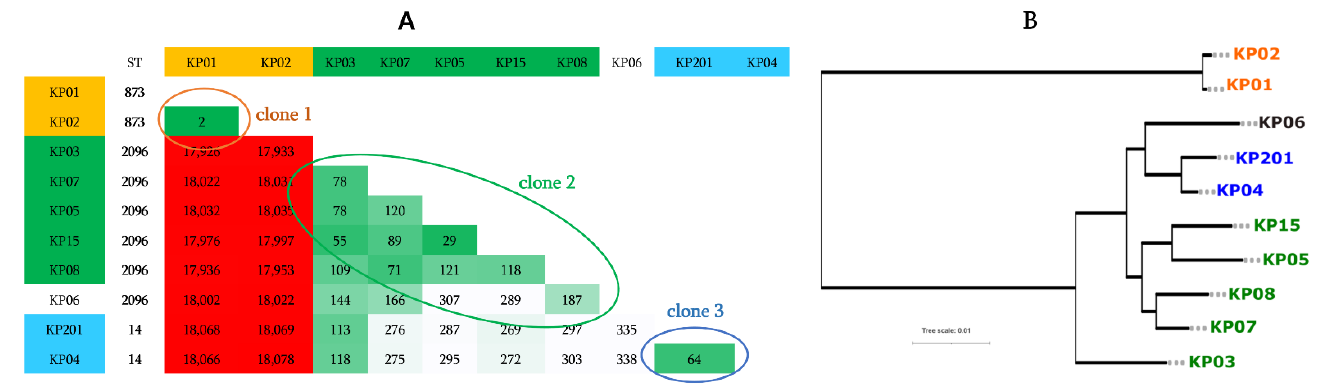
Figure 3. Genomic characterization of K. pneumoniae isolates. ( A ) Pairwise comparison of genomic gSNPs of K. pneumoniae showing the three distinguished sub-clones; ( B ) whole-proteome-based phylogenetic tree of K. pneumoniae isolates.